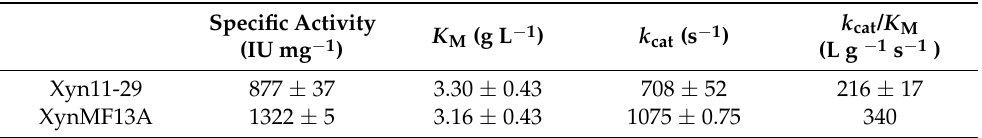
Table 3. Kinetic constants of the recombinant Xyn11-29 produced in P. pastoris . Experiments were per- formed in triplicate against beechwood at various concentrations in the range 1–10 g L − 1 . Activities were measured at 40 ◦ C pH